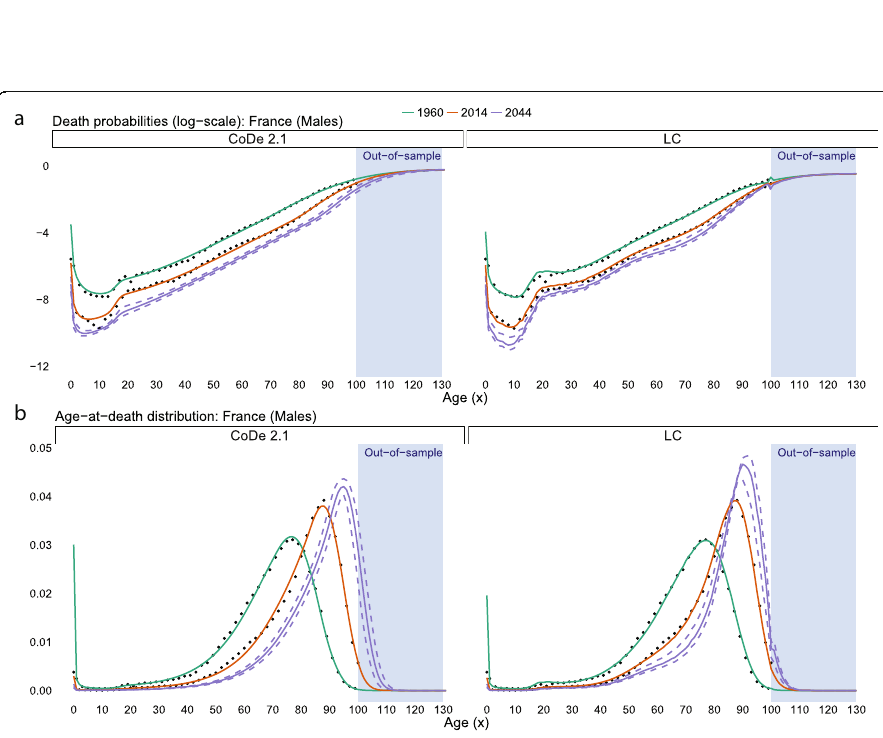
Fig. 7 Estimations and projections of the death probabilities and the age-at-death distribution for France males for the years 1960, 2014, and 2044 and for ages 0 – 130. CoDe 2.1 (left) and LC (right). The dotted lines are observations and the dashed lines are 95% projection intervals. The reference period is 1960 – 2014 for ages 0 –